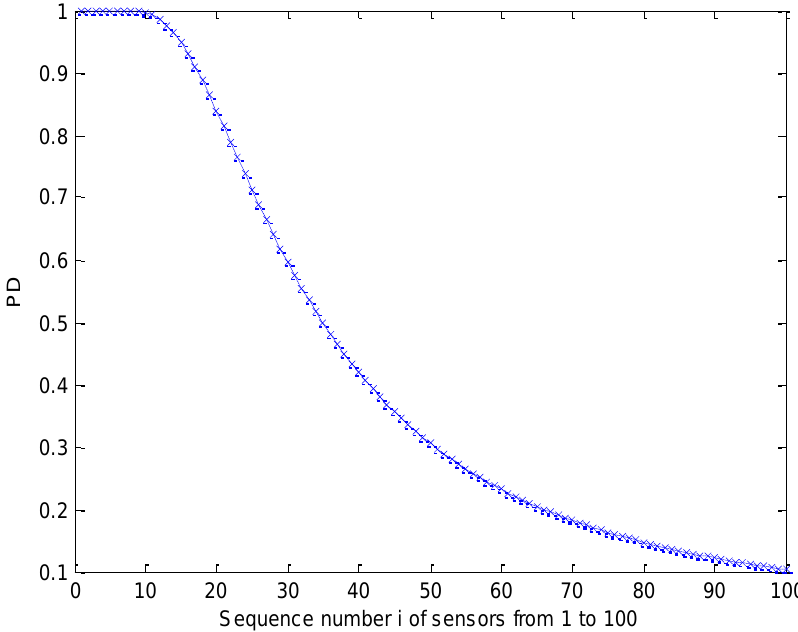
E P evaluation results of the target from sensor 1 to sensor 100. Figure 3. The E ( P Figure 3. The ( ) ) evaluation results of the target from sensor 1 to sensor D i i D